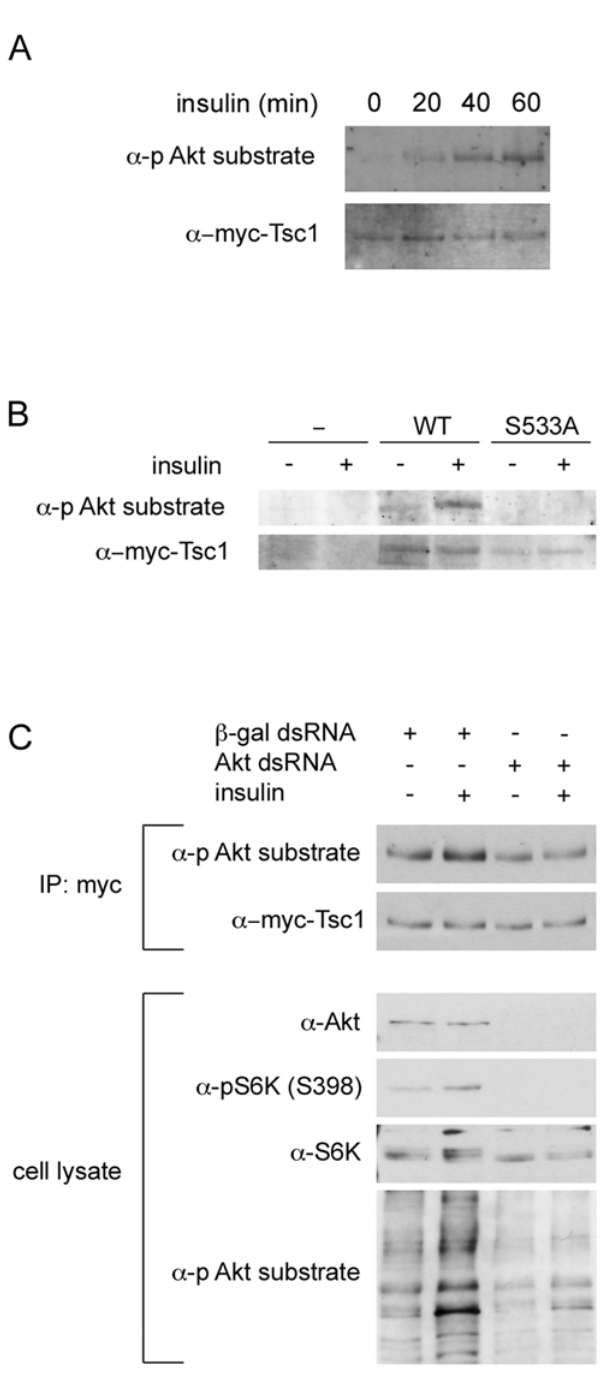
Figure 1. Drosophila Tsc1 is phosphorylated by Akt on Ser533. (A) Phosphorylation of Tsc1 increases with insulin treatment. S2 cells transfected with constructs to express myc-Tsc1 and His-Tsc2 were treated without insulin (0 min) or with insulin (10 m g/mL) for indicated times (20, 40 or 60 min). Cells were then lysed and myc-Tsc1 immunoprecipitated using anti-myc antibody. Immunoprecipitates were probed with anti-myc antibody as a loading control, and anti- Phospho-(Ser/Thr) Akt Substrate antibody to detect phosphorylation of Tsc1. (Ser533 is part of an Akt phosphorylation consensus motif). (B) Tsc1 is phosphorylated on Ser533 in response to insulin treatment. Untransfected S2 cells (-) or S2 cells transfected with constructs to express either myc-Tsc1 WT (‘‘WT’’) or myc-Tsc1 S533A (‘‘S533A’’) together with His-Tsc2 were treated with or without insulin (10 m g/mL) for 1 hour prior to lysis and immunoprecipitation with anti-myc